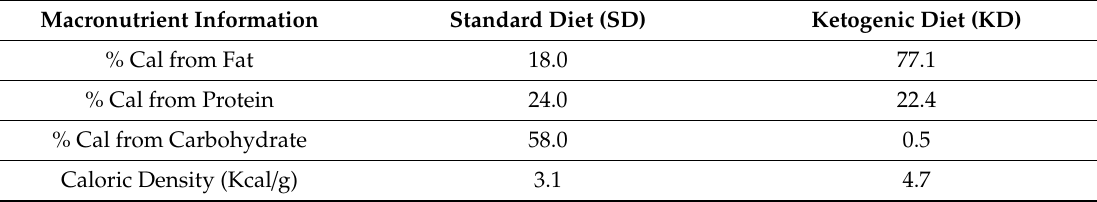
Table 2. Macronutrient ratios of rodent standard diet and ketogenic diet